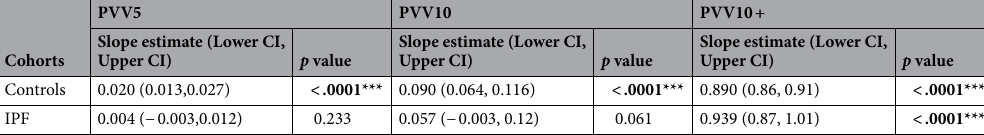
Table 3. Relationship between estimated PVV and its subvolumes: PVV5, PVV10 and PVV10 + . Data are given for the slope estimate (mL/mL) and upper and lower confidence interval (CI) values